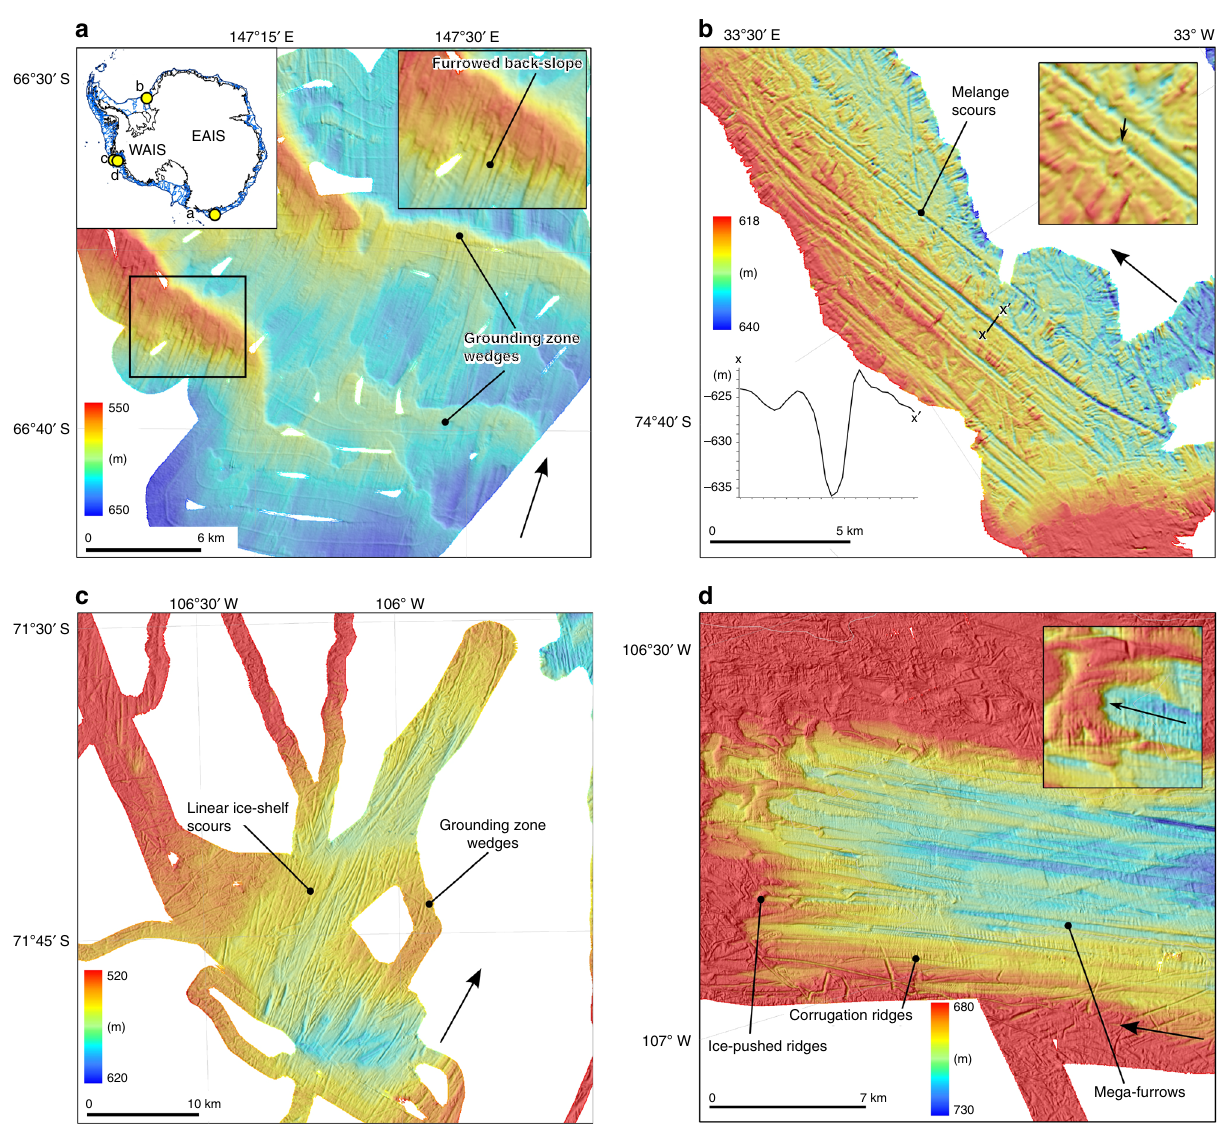
Fig. 6 Landforms associated with ice shelf presence and absence. a Large grounding zone wedges crossing the Mertz Trough (30 m grid cell size), indicative of grounding line positions constrained by the presence of an ice shelf 148 . The backslopes of the wedges (inset, top-right) are marked by sub- parallel furrows that may have formed during ice-sheet lift-off. Map inset (top-left) shows location of panels a – d . − 700 m (dark blue) and − 500 m (light blue) bathymetric contours are shown to illustrate general continental shelf morphology. Colours and corresponding scales depict depth below sea level in metres in panels a – d . b Melange scours (Filchner Trough, 25 m grid cell size 91 ) indicative of ice-shelf presence, particularly their sub-parallel geometry. Inset highlights an along-track ‘ kink ’ in the scours which shows they are not subglacial bedforms. c Linear ice-shelf keel scours on the tops of grounding zone wedges in outer Pine Island Trough (30 m grid cell size) recording the transition from grounded ice-sheet to fl oating ice-shelf 93 . d Range of landforms associated with retreating ice shelves (Pine Island Trough, 20 m grid cell size 93 ), including corrugation ridges, mega-furrows and ice-keel plough ridges. Inset shows one of the ice-pushed ridges in detail. Black arrow (inset) is direction of ice keel motion to generate ice-keel plough